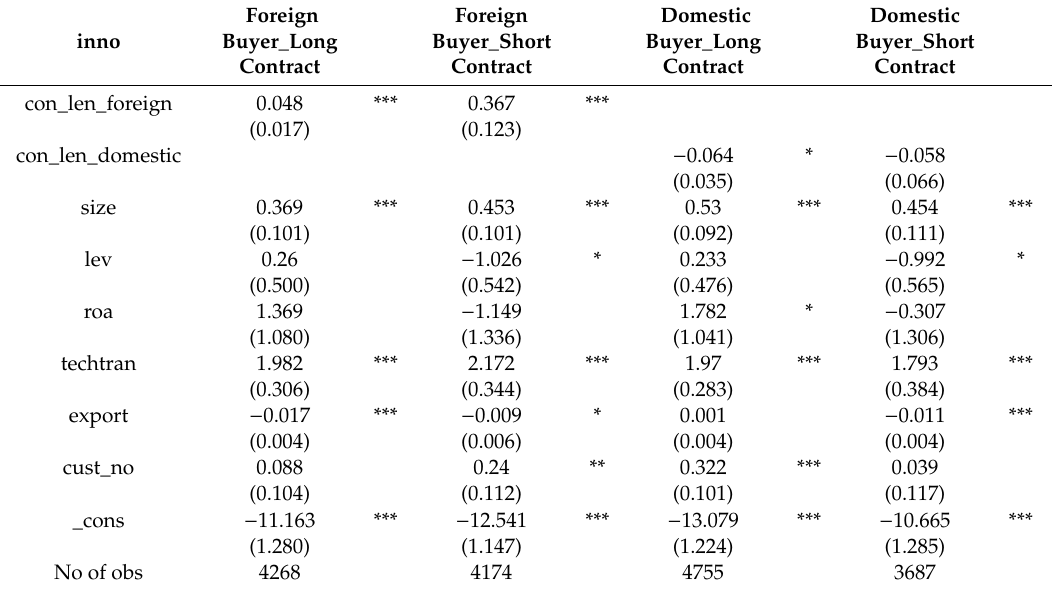
Table 5. Impact of contract length and firm innovation—subsamples.